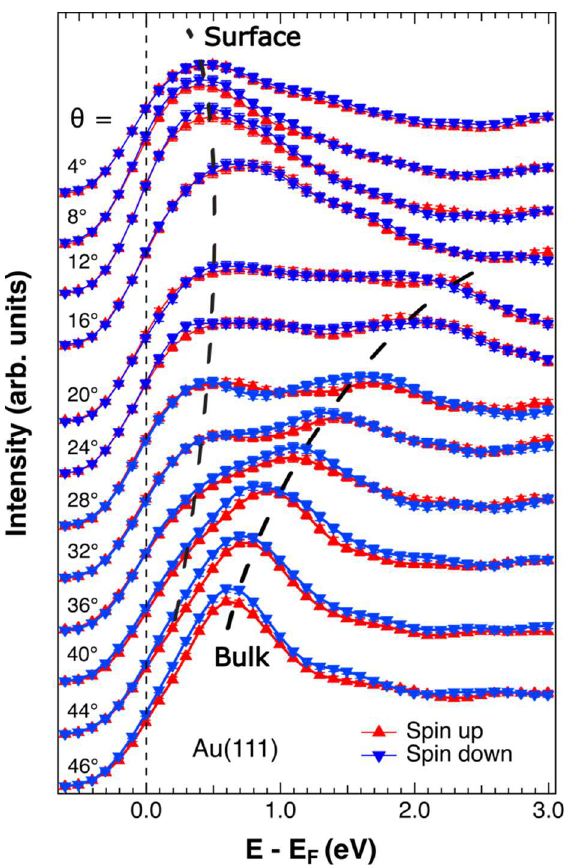
Fig. 2. SPIPES spectra of Au(111) along G M at room temperature. Surface and bulk states are present. Lines are added as a guide to the eye.